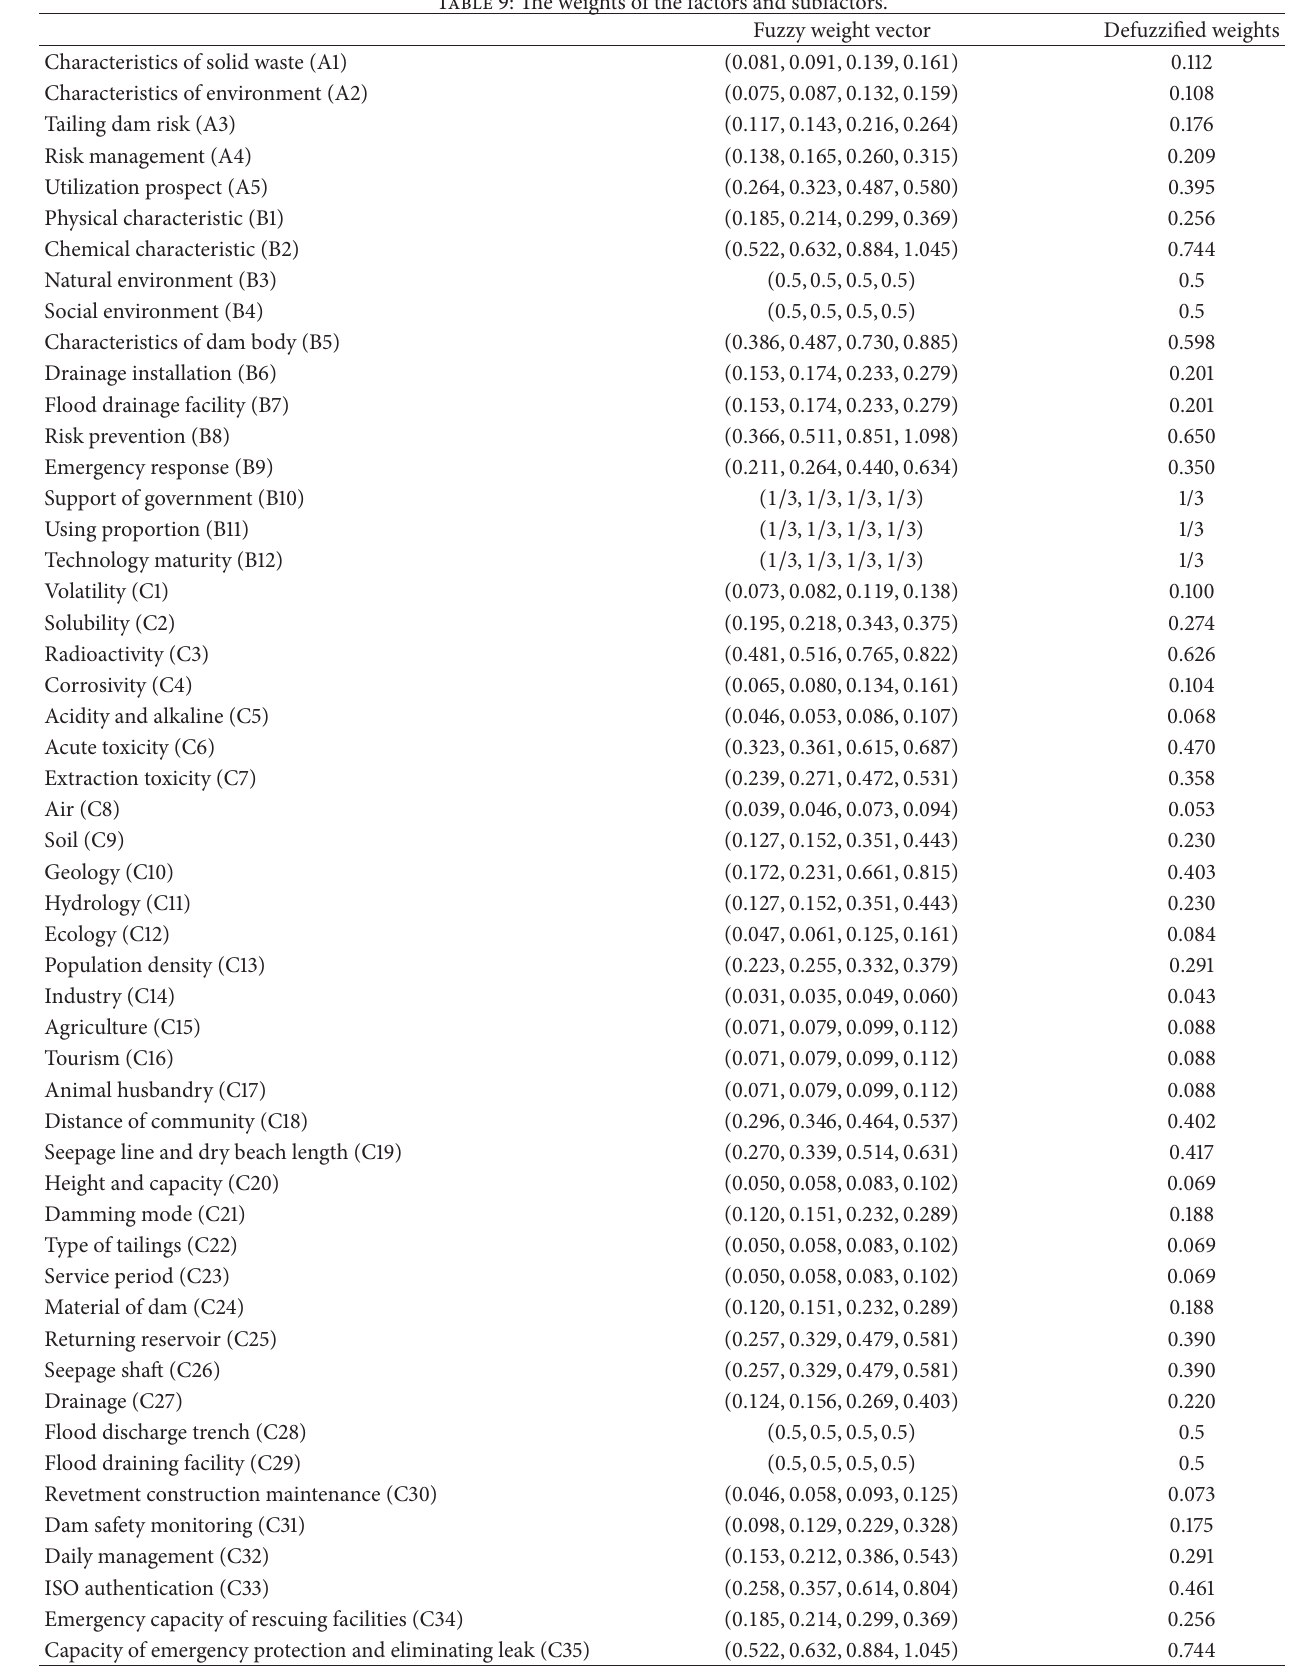
Table 9: The weights of the factors and subfactors.